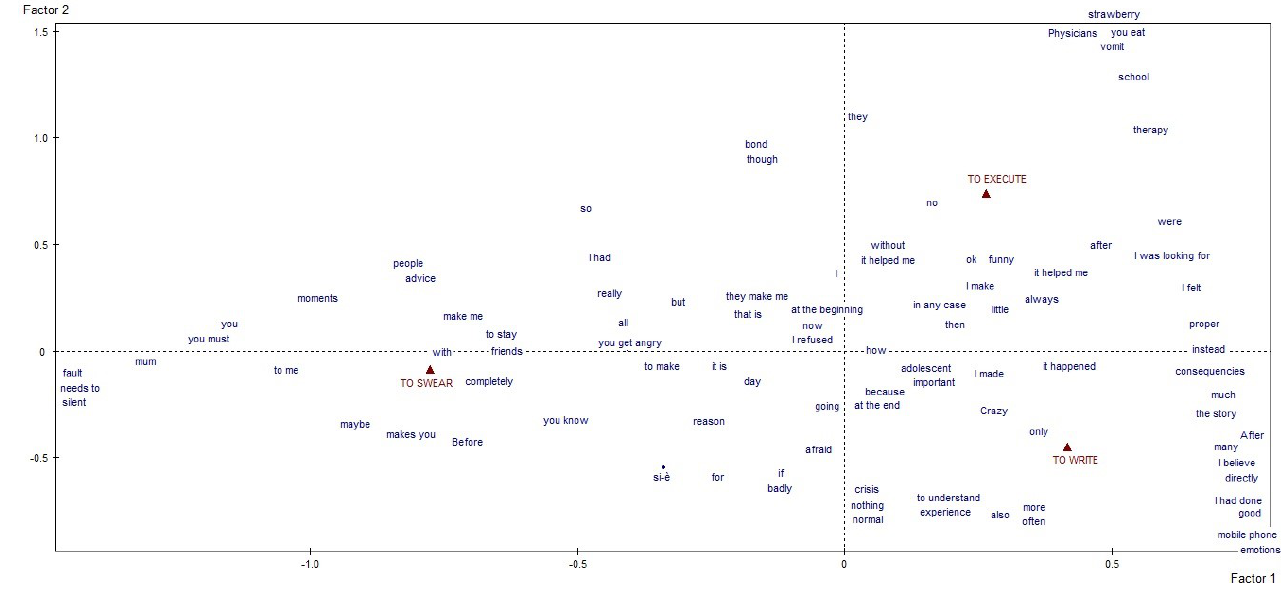
Figure 4. Graphic representation of the forty outcome, about “the modalities for reacting to the disease and its